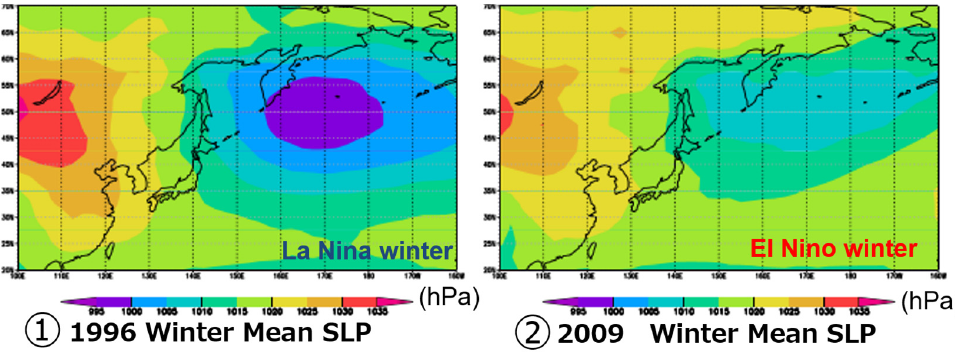
Figure 11. Winter mean sea level pressure (SLP) for years ( left ) 1996 and ( right ) 2009.